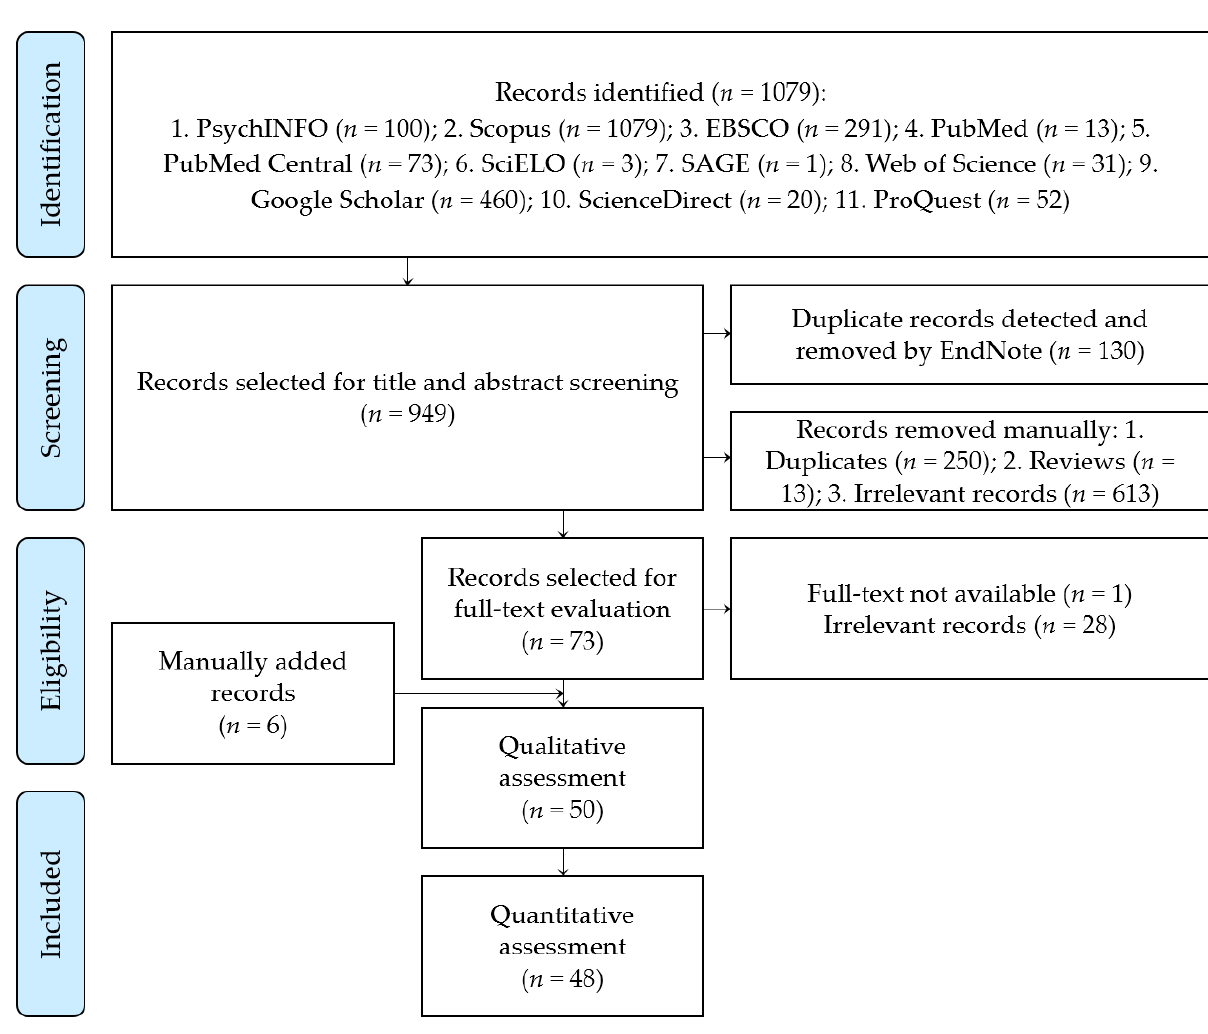
Figure 1. PRISMA flow chart of the included studies.